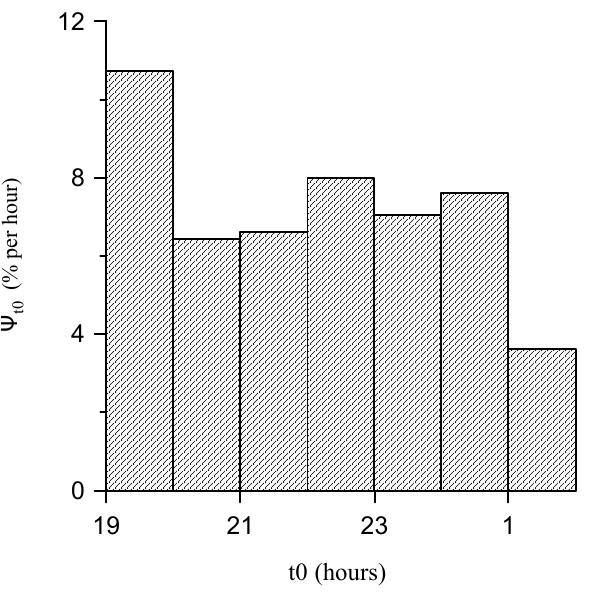
Fig. 7. The statistical distribution of NETE amplitudes in 200K